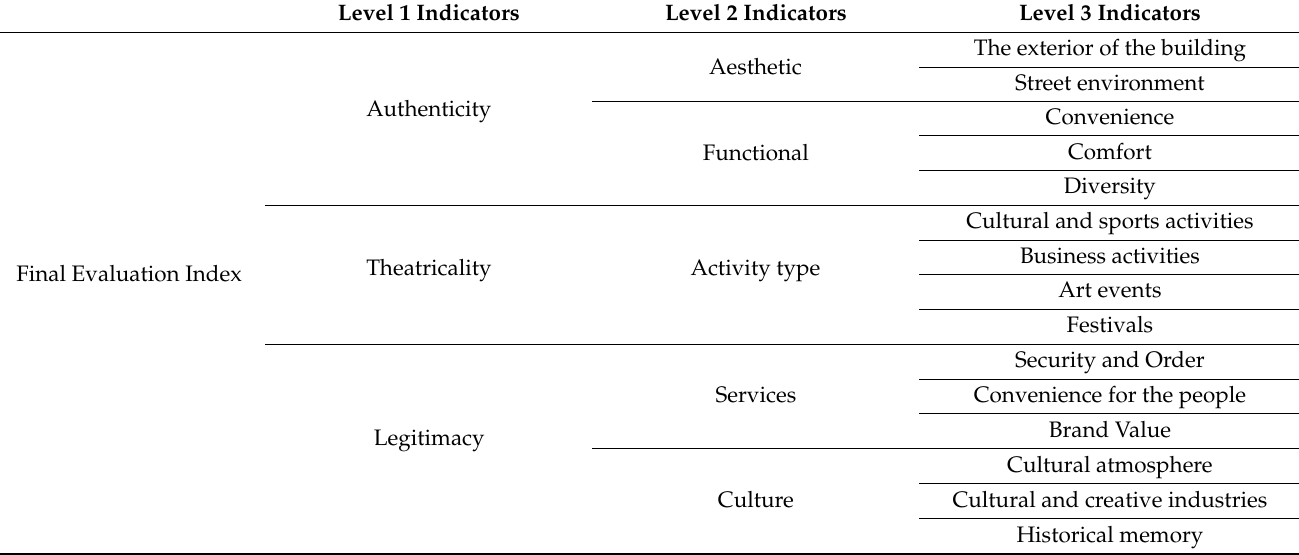
Table 2. Final evaluation